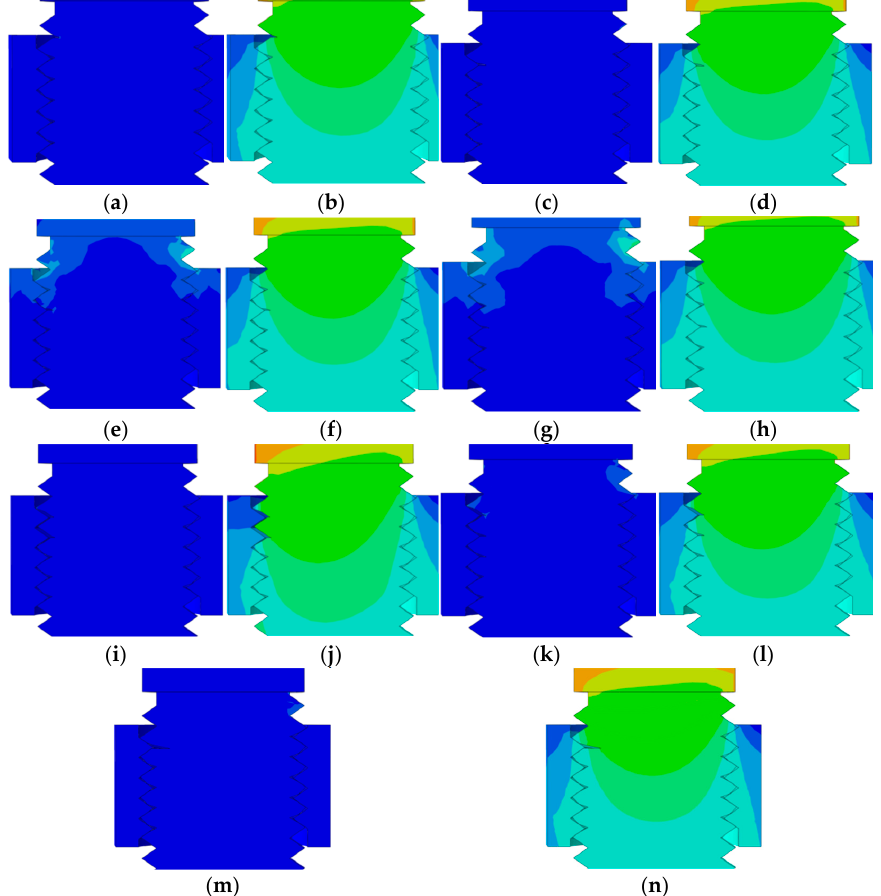
Figure 11. Simulated stress and displacement diagram of bolts with cracks. ( a ) M1-S; ( b ) M1-U; ( c )